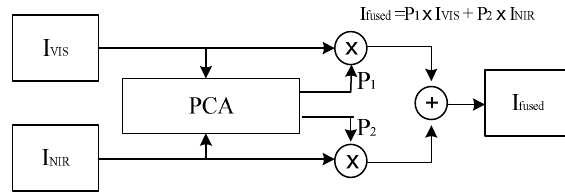
Figure 2. Principal component analysis (PCA) fusion block diagram.